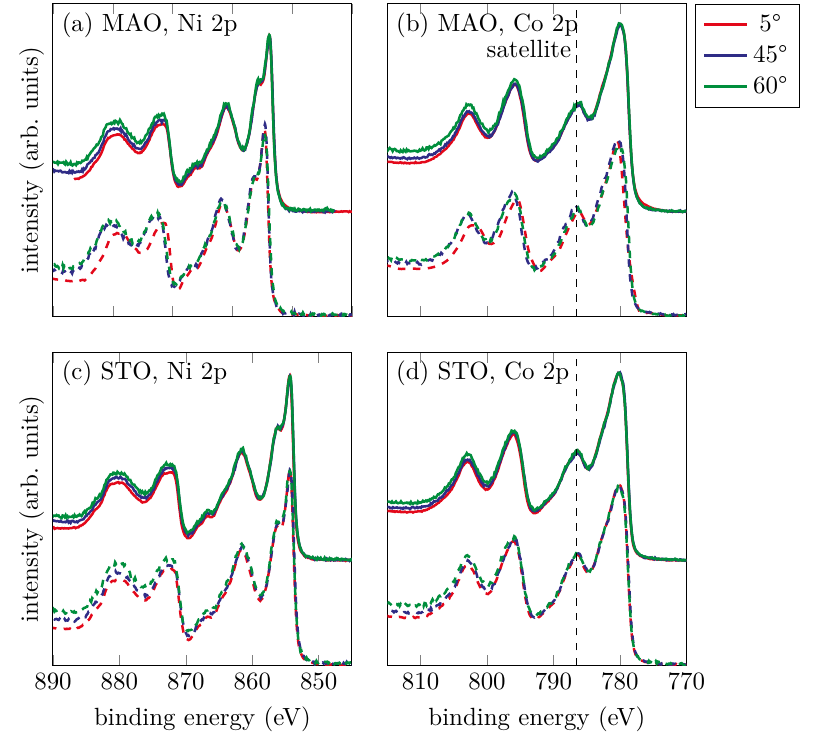
Figure 8. HAXPES measurements for the films on MAO ( a , b ) and STO ( c , d ) substrates for several photoemission angles. The solid lines represent the films prepared with O 2 while the dashed lines represent the films prepared with O ∗ . All data were scaled to maximum intensity for better comparability. Regardless of the oxygen used, the shape of the spectra was identical for all